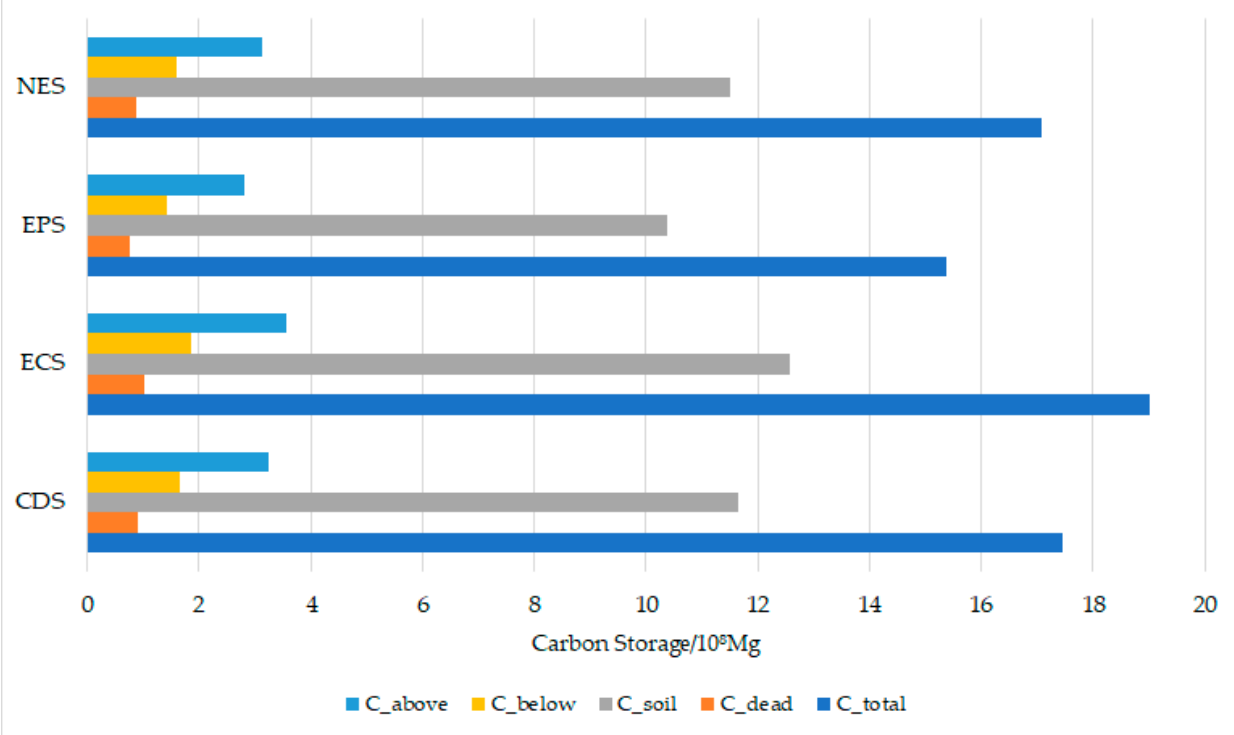
Figure 9. The predicted basic carbon storage in 2050 under four scenarios.